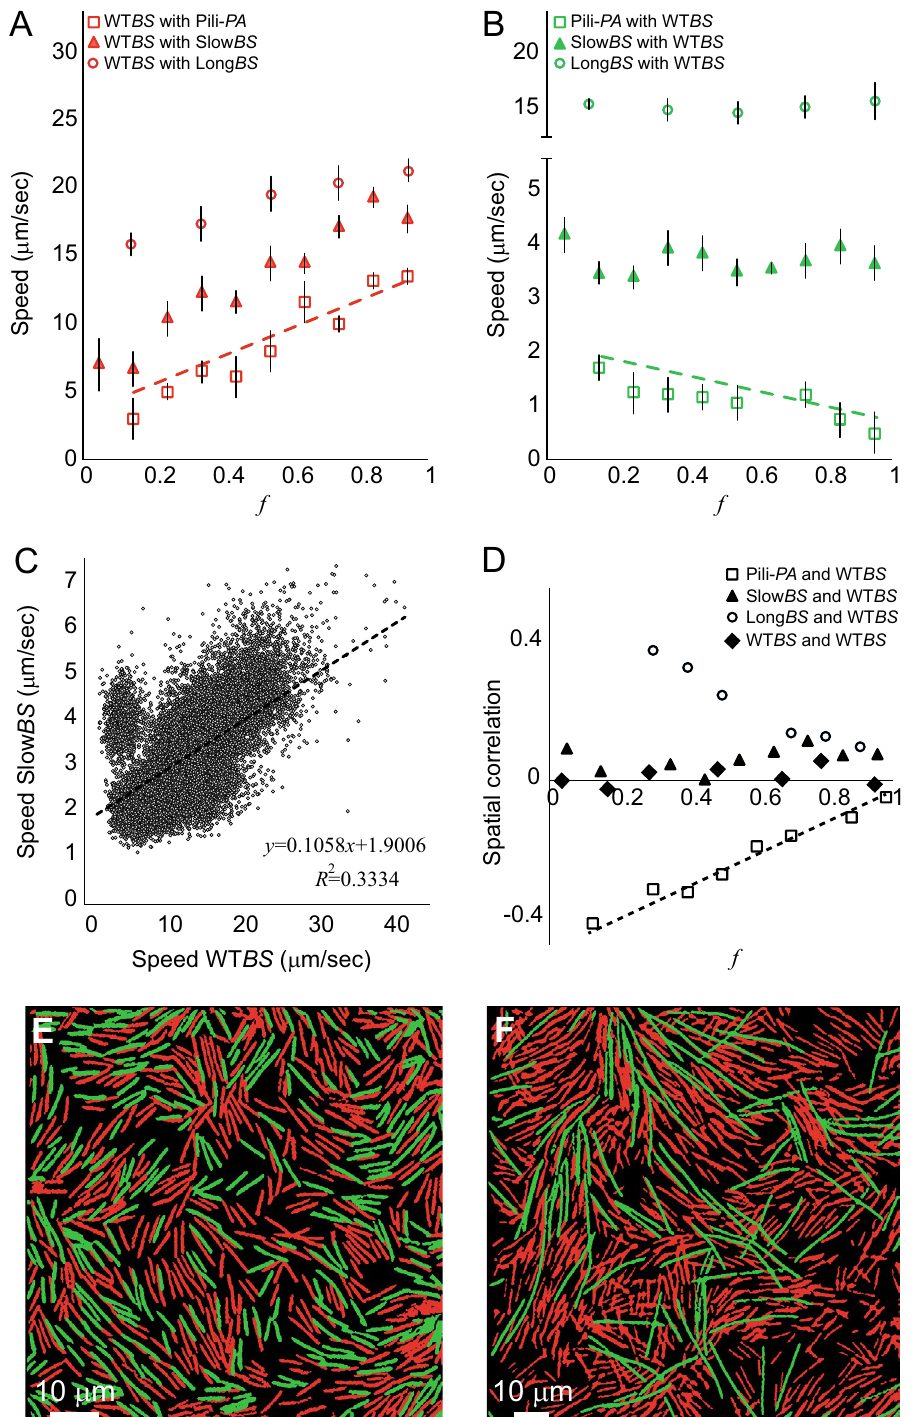
Figure 4. Dynamics analyses of swarm colonies composed of WT B. subtilis mixed with a mutant. ( A ) The average speed of the WT B. subtilis as a function of f at a fixed area fraction ρ = 0.25, for 3 mixed cases: pili-defective P. aeruginosa (open squares), slow B. subtilis (solid triangles), and long B. subtilis (open circles). All results show an increase with approximately the same slope . The dashed line indicates data from Fig. 2 (mixing with the WT P. aeruginosa ). ( B ) The average speed of the mutant mixed with the WT B. subtilis as a function of f (the density ratio of B. subtilis ). While results with WT P. aeruginosa show a decrease, results with the two B. subtilis strains do not. The dashed line indicates data from Fig. 2 (mixing with the WT P. aeruginosa ). ( C ) The speed of slow B. subtilis as a function of the speed of WT B. subtilis , pooled overall ρ and f , shows a strong positive correlation. Note the difference compared to Fig. 2D. ( D ) The correlation in spatial distribution as a function of f for the 3 mixed cases: pili-defective P. aeruginosa (open squares), slow B. subtilis (solid triangles), and long B. subtilis (open circles). The dashed line indicates results from Fig. 2 (mixing with the WT P. aeruginosa ). Data is shown also for the case of two WT B. subtilis that differ in their fluorescence color. ( E ) A microscopic view of the mixed cells with WT B. subtilis (green) and slow B. subtilis (red). Measurements show ~ 0 spatial correlation. ( F ) A microscopic view of the mixed cells with WT B. subtilis (red) and long B. subtilis (green). Measurements show positive spatial